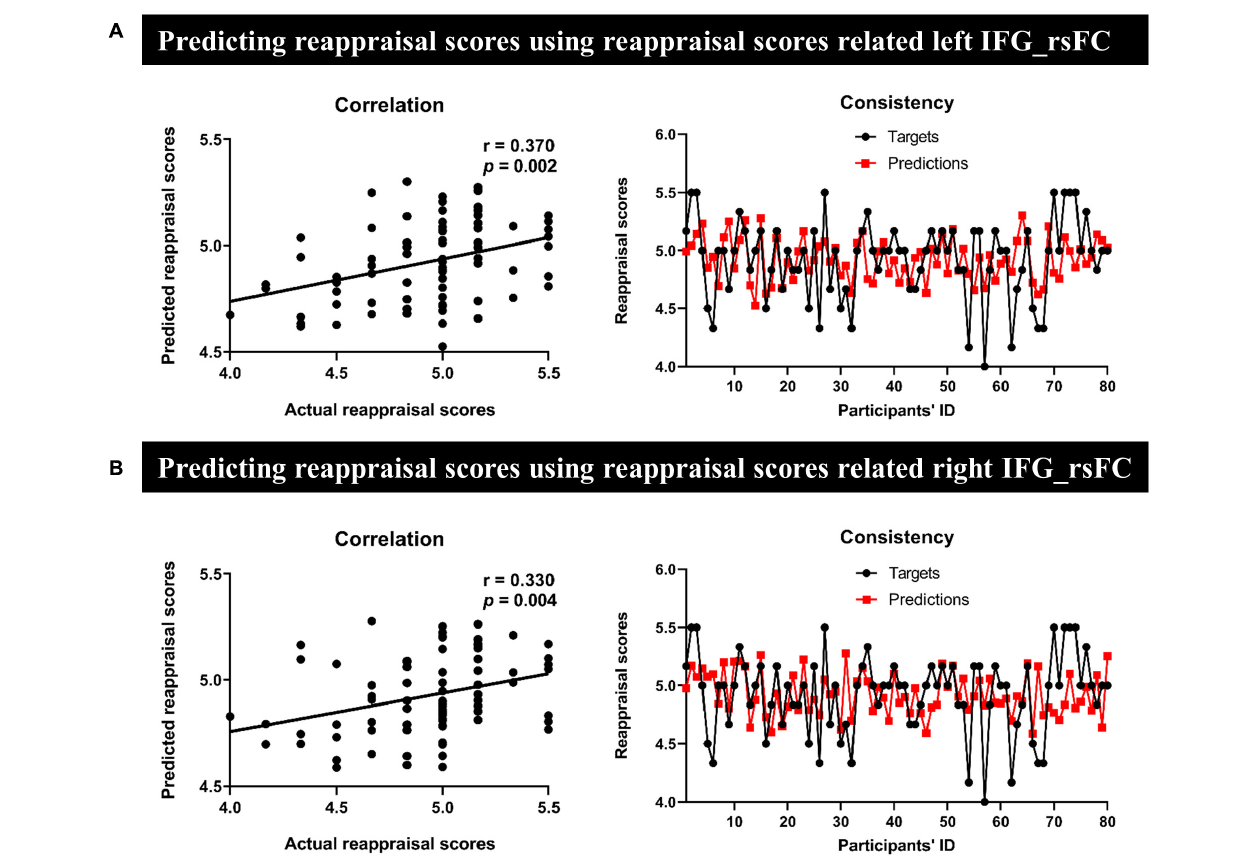
FIGURE 4 | Results of prediction in MRG. Severally using (A) the left and (B) the right IFG-based rsFC to predict reappraisal scores. The scatter plots and line charts [in both panels (A,B) ] described a significant correlation and consistency between actual and predicted reappraisal scores, respectively.